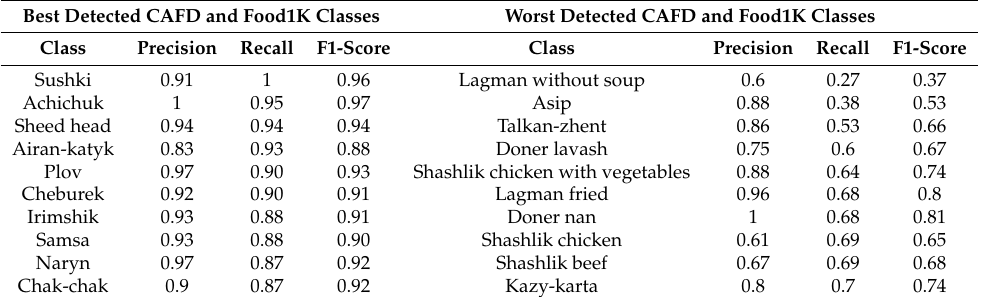
Table 5. Ten CAFD and Food1K classes best and worst detected by the EfficientNet-b4 model. Best Detected CAFD and Food1K